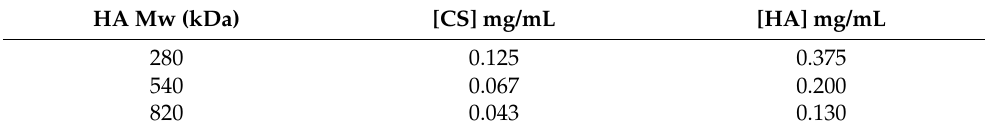
Table 1. HA and CS solutions concentrations for the synthesis of NPs based on the HA Mw